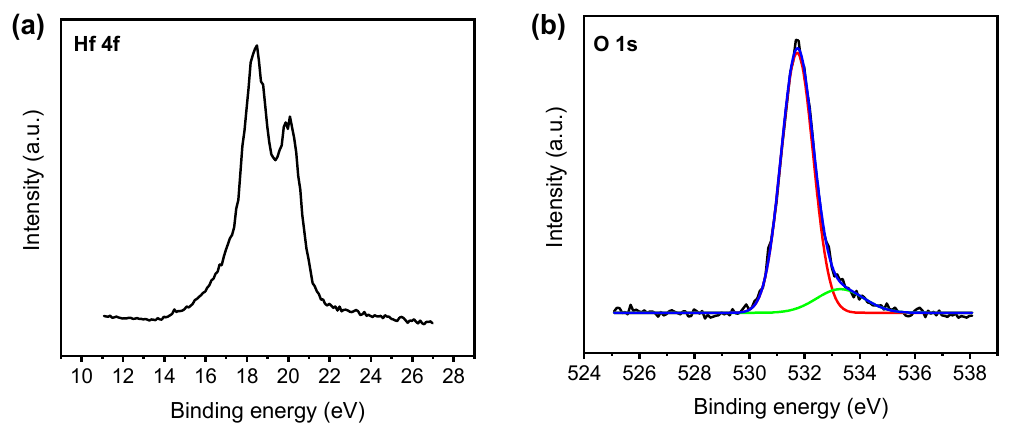
Figure 1. XPS spectra of the HfO 2 film on Si substrate: ( a ) Hf 4f and ( b ) O 1s.